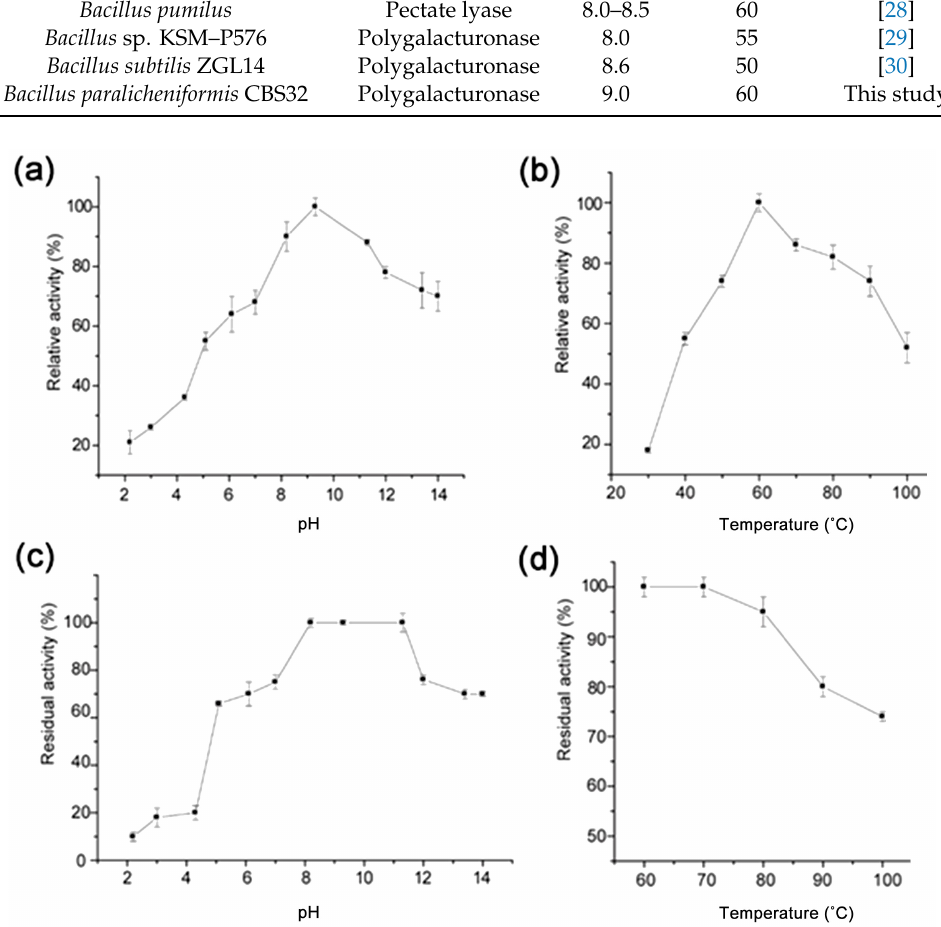
Figure 4. ( a ) Optimum pH, ( b ) optimum temperature, ( c ) pH stability, and ( d ) thermal stability